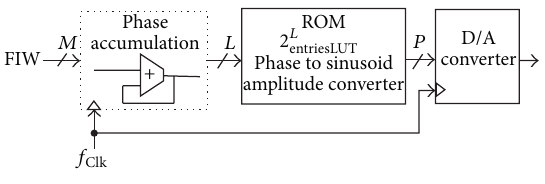
Figure 1: The basic structure of a DDFS.